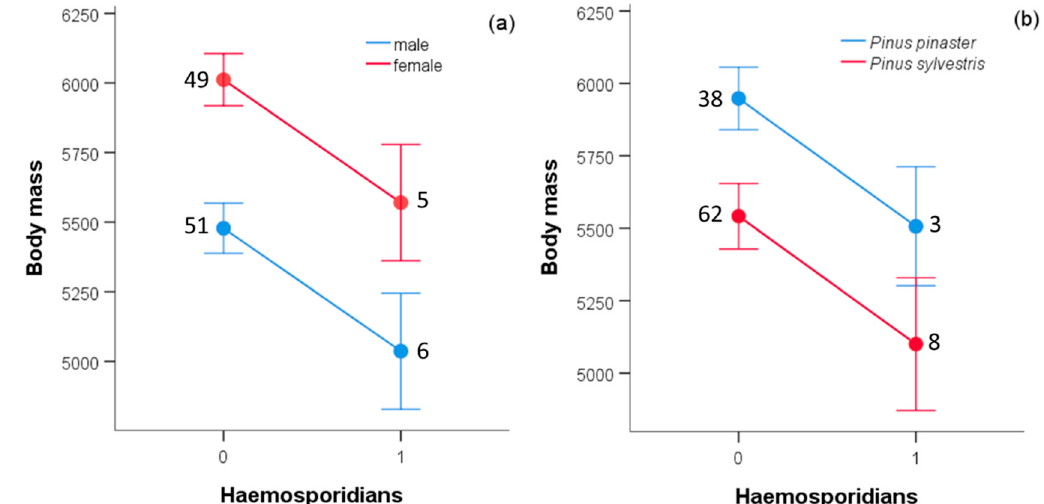
Figure 2. Estimated marginal means ± SE for body mass (in gr) of nestling cinereous vultures according to infection by haemosporidians, and ( a ) sex and ( b ) habitat conditions (dry or humid) associated to pinewoods and nests built in maritime pine ( P. pinaster ) and Scots Pine ( P. sylvestris ), respectively. Numbers represent sample sizes.